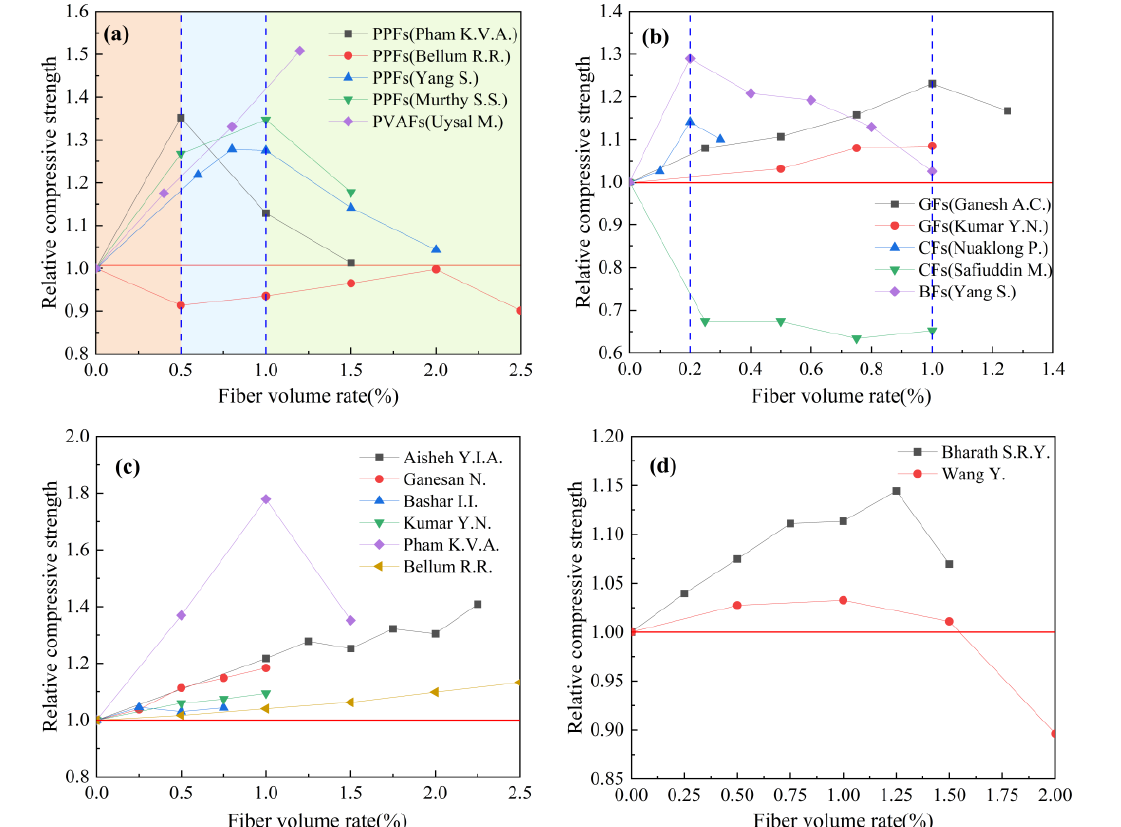
Figure 13. The effect of fiber volume rate on compressive strength: ( a ) Synthetic fiber; ( b ) inorganic fiber; ( c ) steel fiber; ( d ) plant fiber.